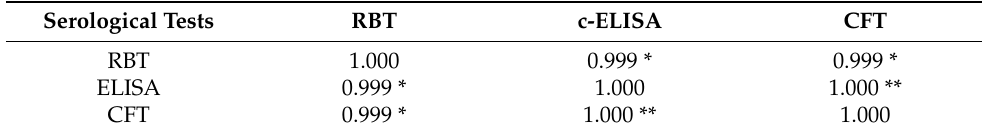
Table 3. Pearson’s correlation coefficients among the serological tests.